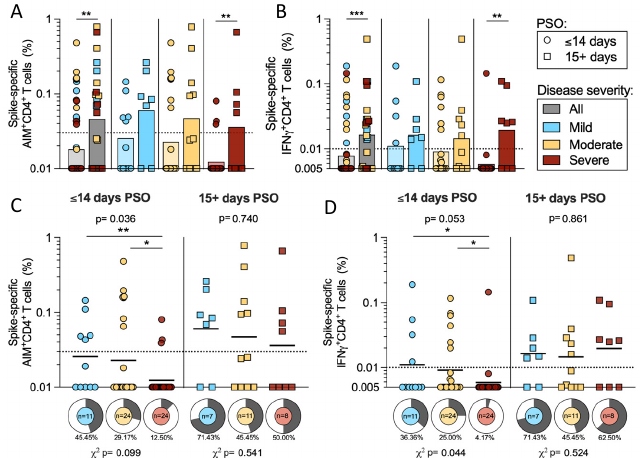
Figure 4. Early and late CD4+ T cell responses to SARS-CoV-2 S. The cohort of acute donors was divided by ≤ 14 days PSO (early) and 15+ days PSO (late), and the PBMCs were tested for CD4+ T cell reactivity to SARS-CoV-2 spike by AIM and IFN γ ICS. The magnitude of spike-specific CD4 reactivity is shown for mild ( n = 18, blue), moderate ( n = 35, yellow), severe ( n = 32, red), or all ( n = 85, grey) COVID-19 donors (3 mild and 1 severe were excluded from the graph because the days PSO was not reported). The data are shown for the entire cohort and separated for side-by-side comparisons of early and late PSO within disease severities in AIM ( A ) and IFN γ ( B ) ICS. The same data are plotted as shown to compare the T cell responses in AIM ( C ) and IFN γ ( D ) ICS within disease severities. Additionally, pie charts show the frequency of the response for each level of disease severity. The y-axis starts at the LOD and the dotted line represents the LOS, while the solid lines or bars represent geometric mean. p -values are calculated by Kruskal–Wallis across all disease severities and Mann–Whitney U tests are applied as indicated by the symbols when significant. Chi-squared test is applied to the frequencies of response as indicated by the p -values below the pie charts. * p < 0.05, ** p < 0.01, *** p <